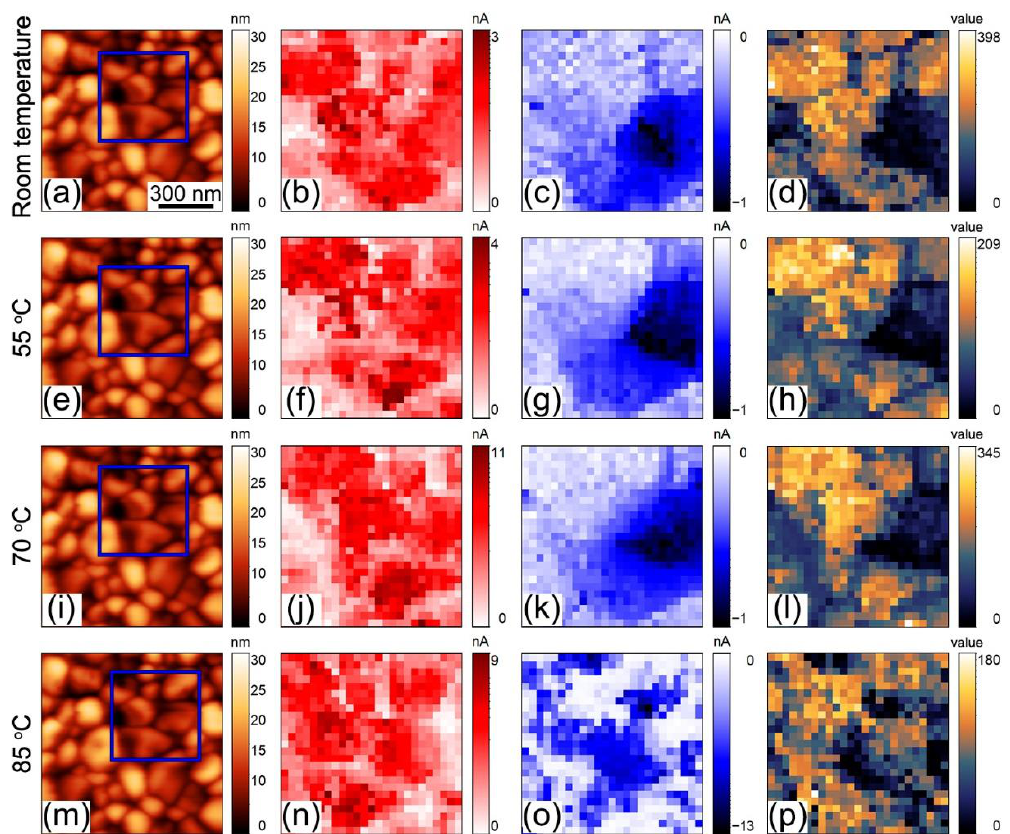
Figure 4. IV dependencies mapping at various temperatures: ( a – d ) 25 °C, ( e – h ) 55 °C, ( i – l ) 70 °C, ( m – p ) 85 °C. ( a , e , i , m ) Topography; current in log-scale ( b , f , j , n ) at U = 10 V and ( c , g , k , o ) at U = −10 V; ( d , h , l , p ) coefficient of asymmetry: current amplitude at 10 V divided on current amplitude at −10 V. Thermal drift is present in ( m – p ). Blue squares in ( a , e , i , m ) indicate the region at the scan, where I–V curve mapping was done in the respective row.